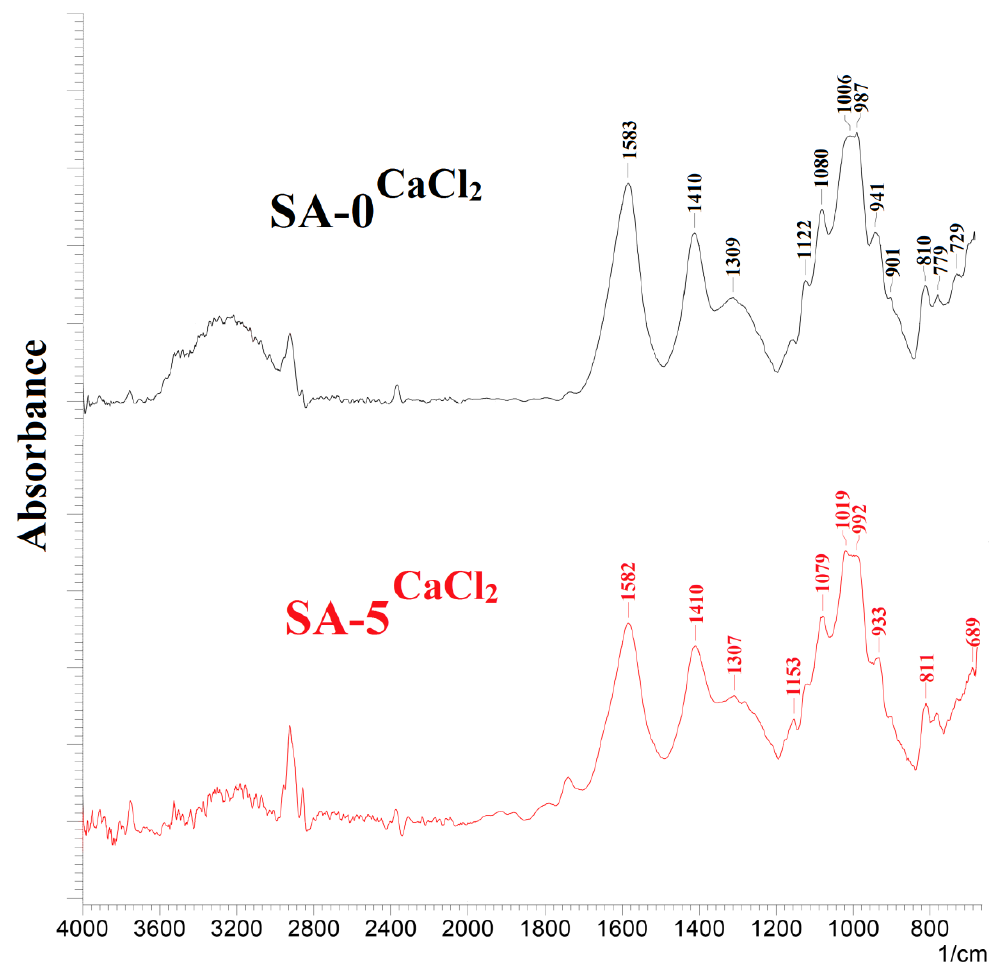
Figure 6. The FTIR spectra for the SA-0 CaCl2 and SA-5 CaCl2 membranes.